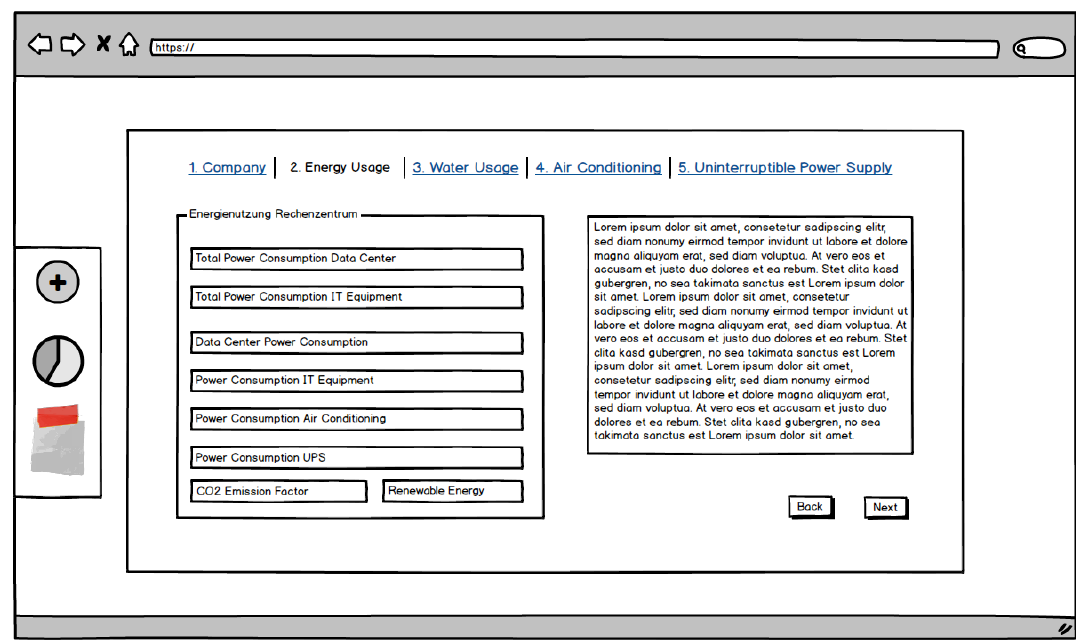
Figure 2. Energy